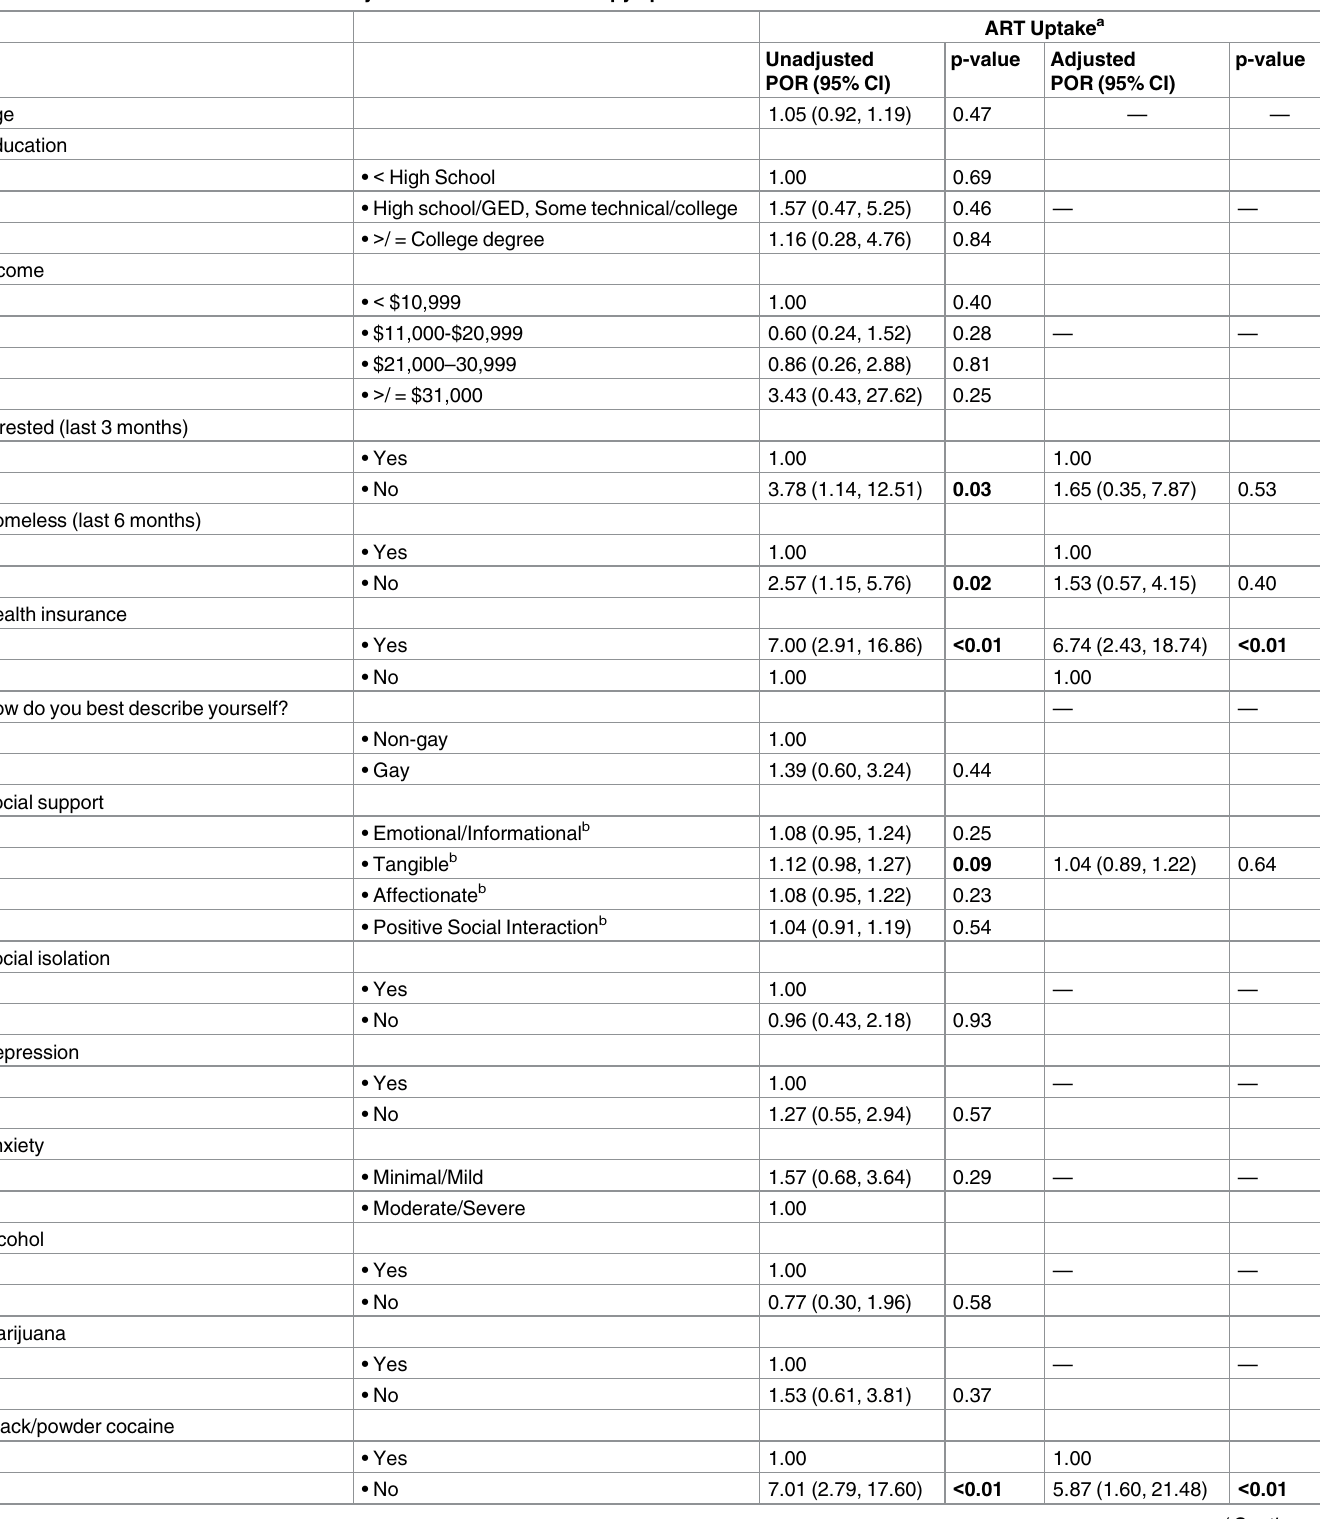
Table 3. Bivariable and multivariable analysis for antiretroviral therapy